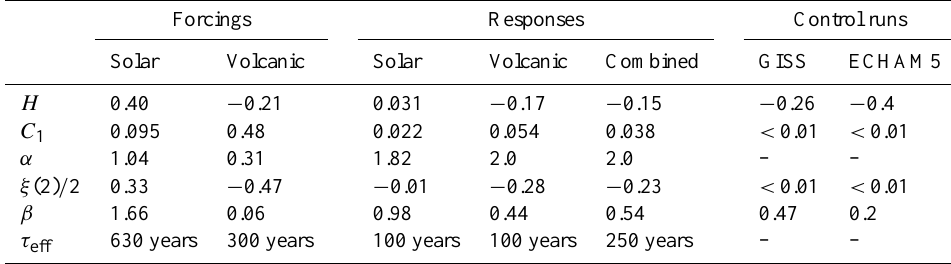
Table 1. The scaling exponent estimates for the forcings and ZC model responses. Forcings Responses Control runs Solar Volcanic Solar Volcanic Combined GISS ECHAM5 H 0.40 − 0.21 0.031 − 0.17 − 0.15 − 0.26 − 0.4 C 1 0.095 0.48 0.022 – – 1.66 0.44 0.47 – – Table 1 shows the scaling exponent estimates for the forcings and ZC model responses. For solar (forcing and response), only the recent 400-year (sunspot-based) series were used; for the others, the entire 1000-year range was used (see Fig. 6a). The RMS exponent was estimated from Eqs. (6) and (9): H was estimated from the Haar fluctuations, and α and C 1 were estimated from the trace moments (Fig. 6a). Note that the external cascade scales are unreliable since they were estimated from a single realization. The control runs on the right are for the GISS-E2-R model discussed in the text and (ECHAM5) from the fully coupled COSMOS-ASOB millennium long-term simulations based on the Hamburg ECHAM5 model for